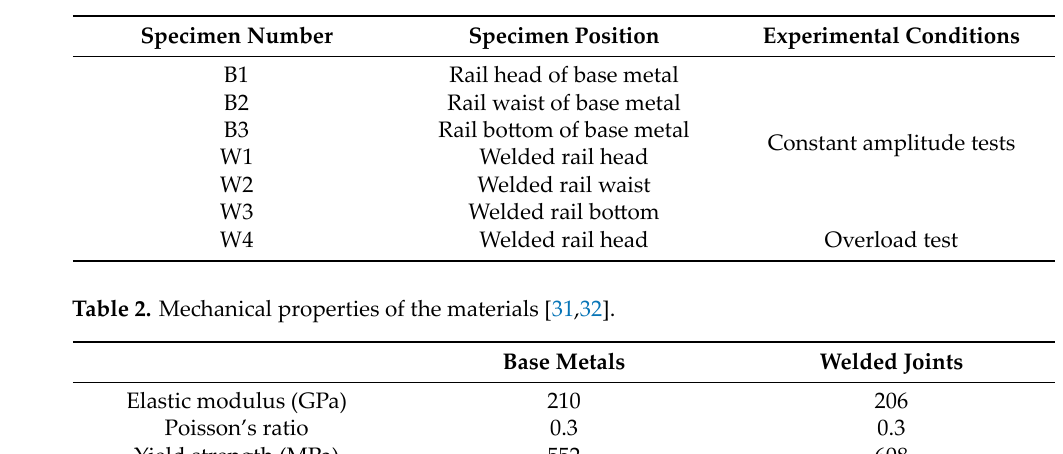
Table 2. Mechanical properties of the materials [31,32].